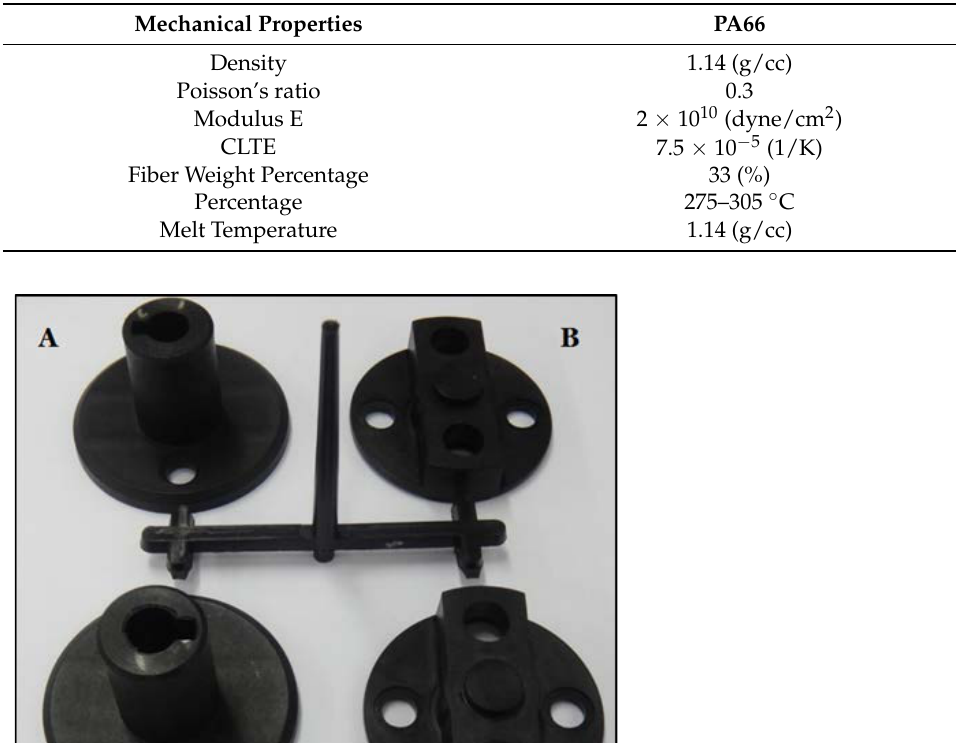
Table 1. PA66 Material Characteristics.